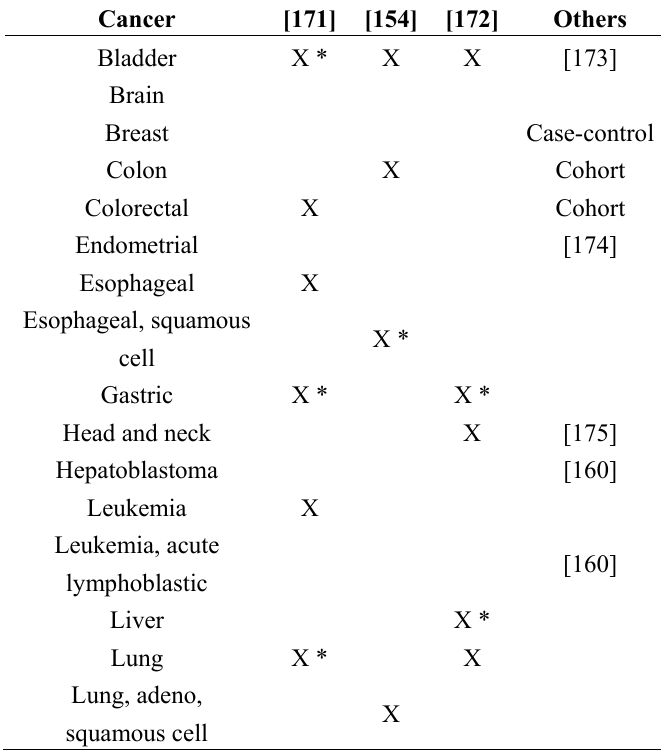
Table 3. Results from observational studies of cancer incidence with respect to UVB irradiance or serum 25(OH)D